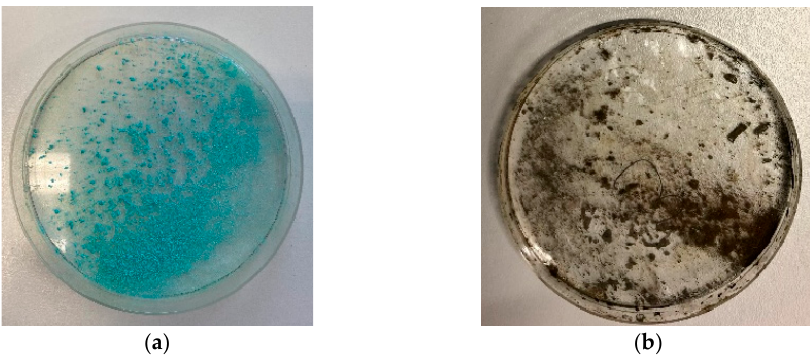
Figure 7. CuCl 2 · 2 H 2 O crystals before ( a ) and after 30 min reductive Varigon low-pressure treatment ( b ). A dark discoloration as indicator for a strong plasma influence can be seen in picture ( b ).